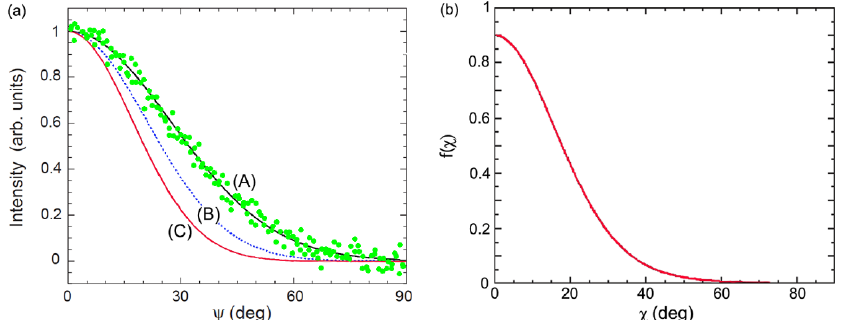
Figure 25. In panel ( a ) are shown: (A, green dots and black line) azimuthal intensity profile (at constant q = 1.4 Å −1 ) of the diffuse wide-angle crescent in a single droplet μ -XRD pattern with the green dots and the full black line representing the experimental data and their best fit by a Gaussian lineshape, respectively; (B, dotted blue line) theoretical azimuthal intensity profile that should be obtained with n parallel to N everywhere within the droplet; (C, red line) deconvolution of curves (A) and (B). All the curves are normalized to their maximum value. The panel ( b ) shows the orientational distribution function of the nematic director inside the bipolar droplet. Adapted from [78] with the editor’s permission.